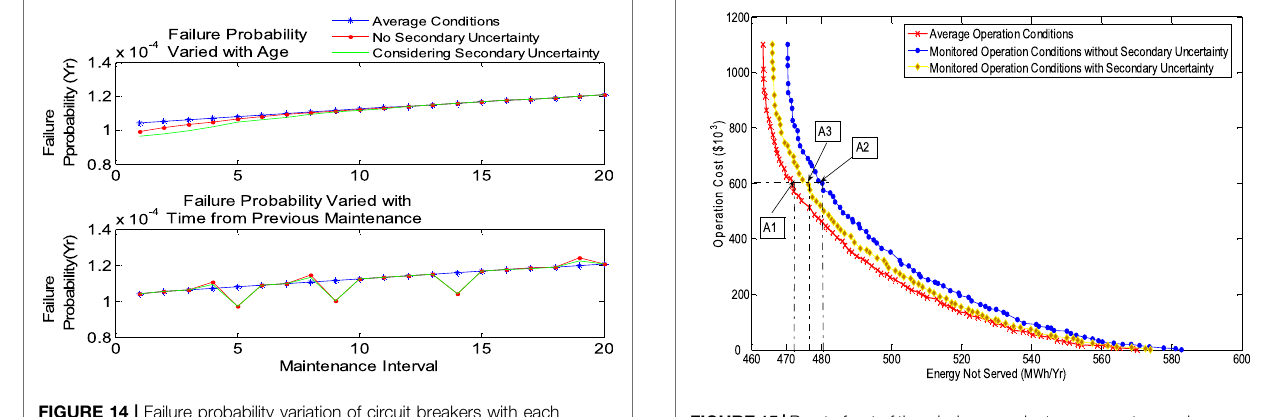
FIGURE15| Paretofront ofthewind power plant: energy not served vs. operation cost.